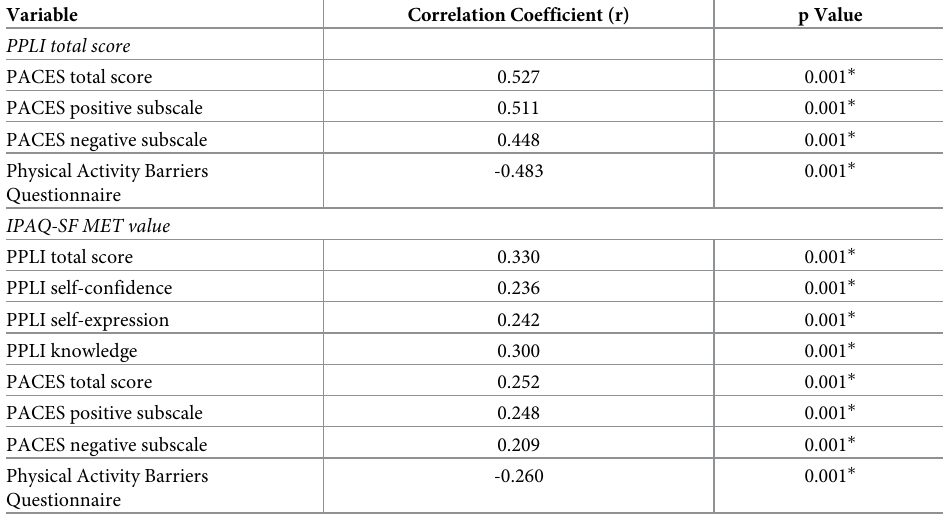
Table 3. Correlation between physical literacy, MET value, level of enjoyment, and barriers to physical activity.